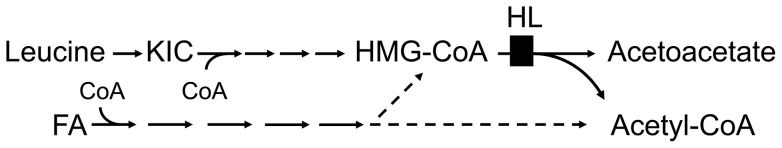
Two metabolic pathways lead to mitochondrial HMG-CoA.Leucine and its metabolite KIC are degraded entirely via HMG-CoA. In hepatic ketogenesis from fatty acid oxidation, a variable fraction of the flux is directed towards HMG-CoA, in response to physiological demands for ketone bodies.